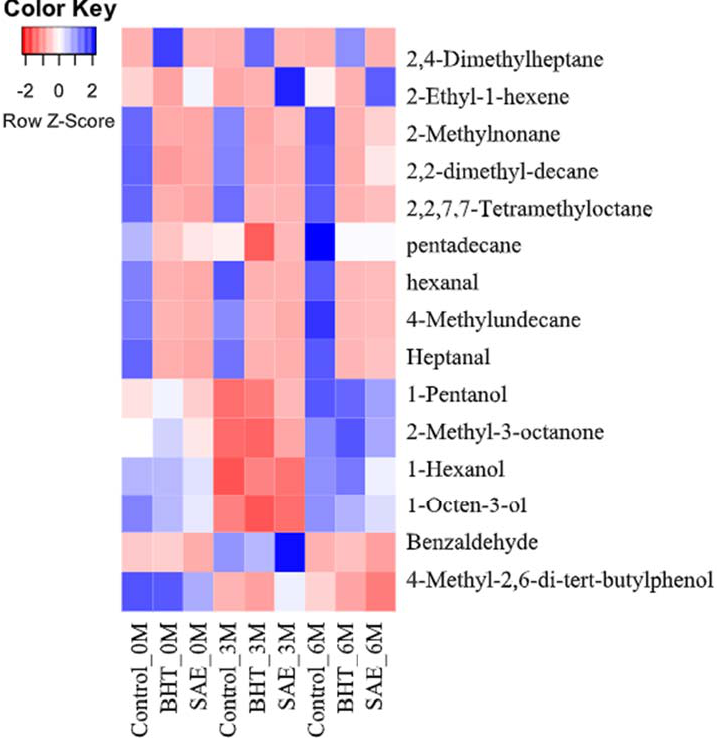
Figure 1. Heat map showing the changing patterns in volatile concentrations based on normalized intensity values across types of cooked ground beef and exhibition time. The volatile compounds were normalized against the abundance of internal standard 2-Methyl-1-pentanol. The red color indicates lesser abundance, and the green color indicates a higher abundance. Con: control; BHT: added 0.02% BHT; SAE: added 0.1% Syzygium aromaticum extract; 0M: 0 month of storage; 3M: 3 months of storage; 6M: 6 months of storage.